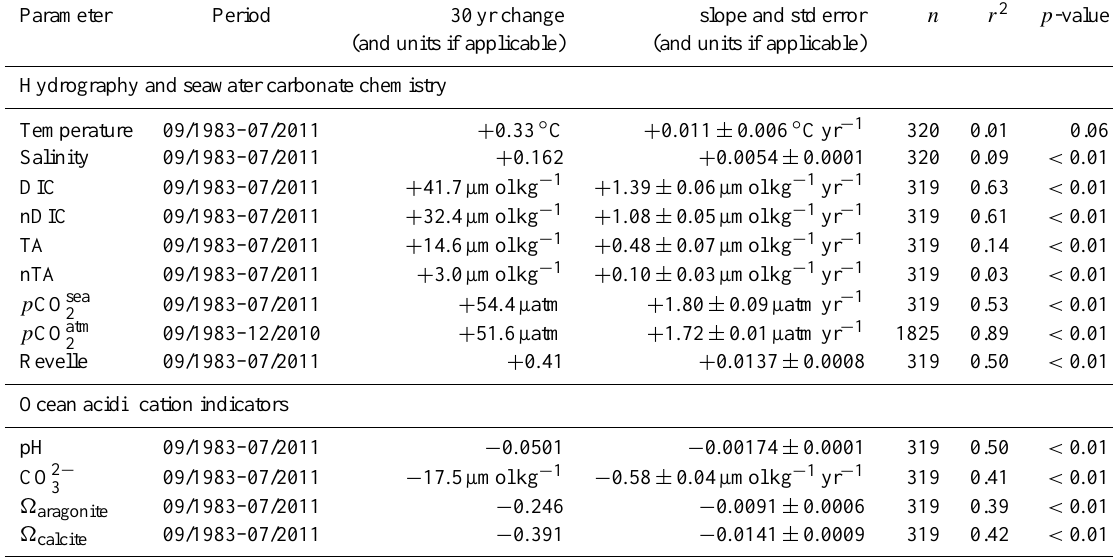
Table 2. Seasonally detrended long-term trends (1983–2011) of surface hydrography and seawater carbonate chemistry with regression statistics (slope and error, n , r 2 and p -value). This table includes trend analysis of surface hydrography including temperature and salinity, seawater carbonate chemistry (i.e., DIC, nDIC, TA, nTA, atmospheric p CO 2 ( p CO atm factor ( β ) anomalies) and indicators of seawater carbonate chemistry changes (e.g., pH, [CO 2 − ( (cid:127) calcite ) and aragonite ( (cid:127) arag ) from the BATS (31 ◦ 40 0 N, 64 ◦ 10 0 W) and Hydrostation S (32 ◦ 10 0 N, 64 ◦ 30 0 W) sites in the North Atlantic Ocean. Please see text for details on the seawater carbonate chemistry computation and salinity normalisation procedures. Observations of atmospheric p CO 2 data come from two atmospheric monitoring sites (Terceira Island, Ac¸ores, September 1983–September 1988; Bermuda, August 1988–December 2010). Please see text for details on the methods for removing seasonal